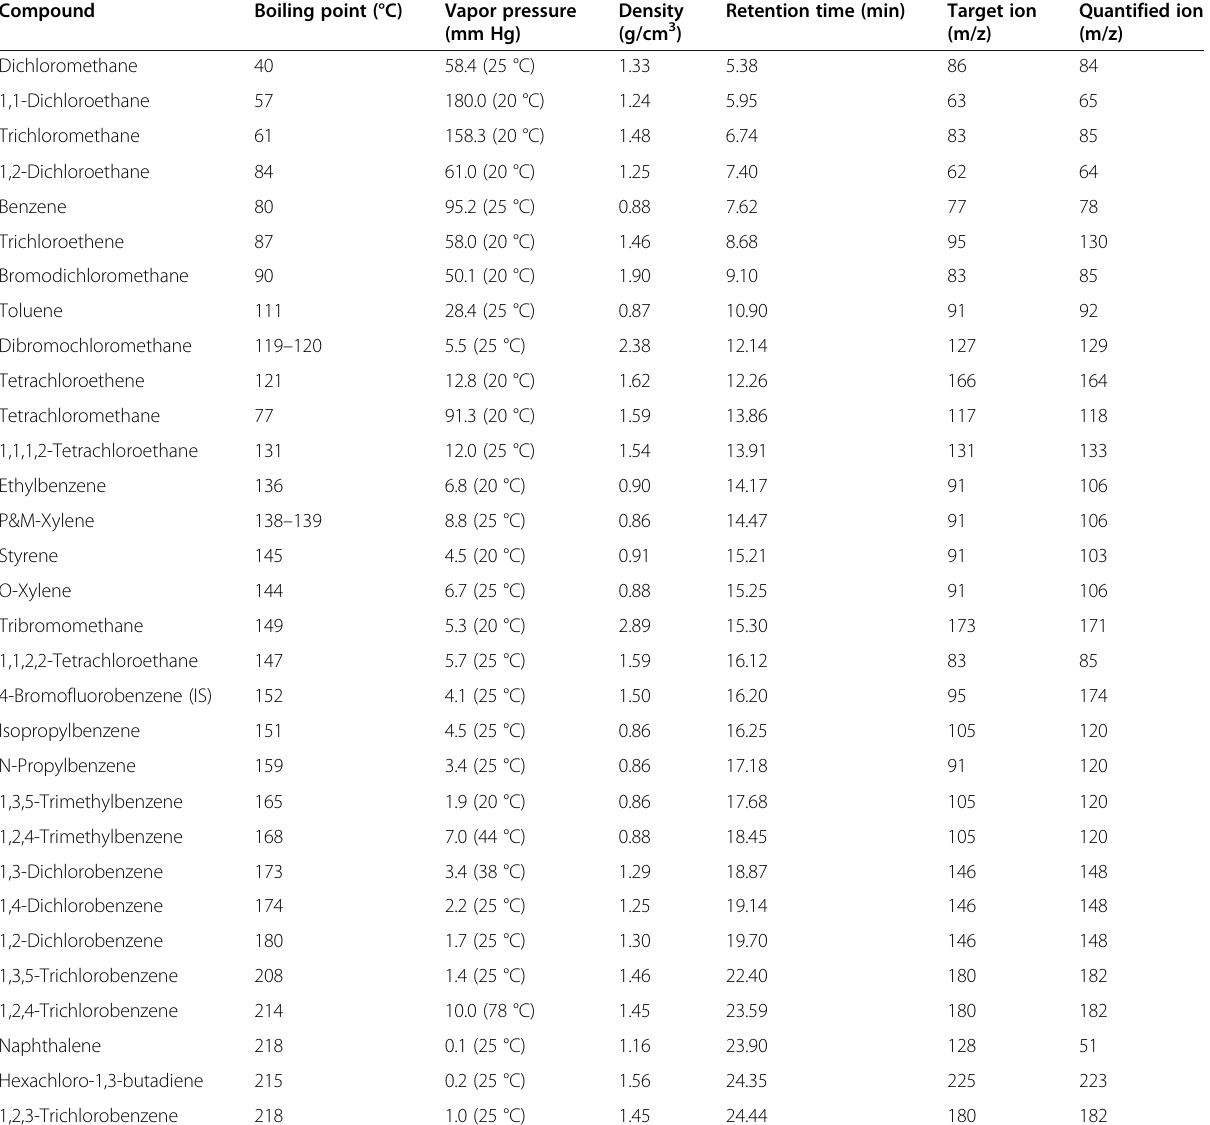
Table 1 Some physical, chemical, and GC-MS properties of VOCs (ATSDR 1997; EPA 2002; Alonso et al. 2011; Güzel et al. 2018)